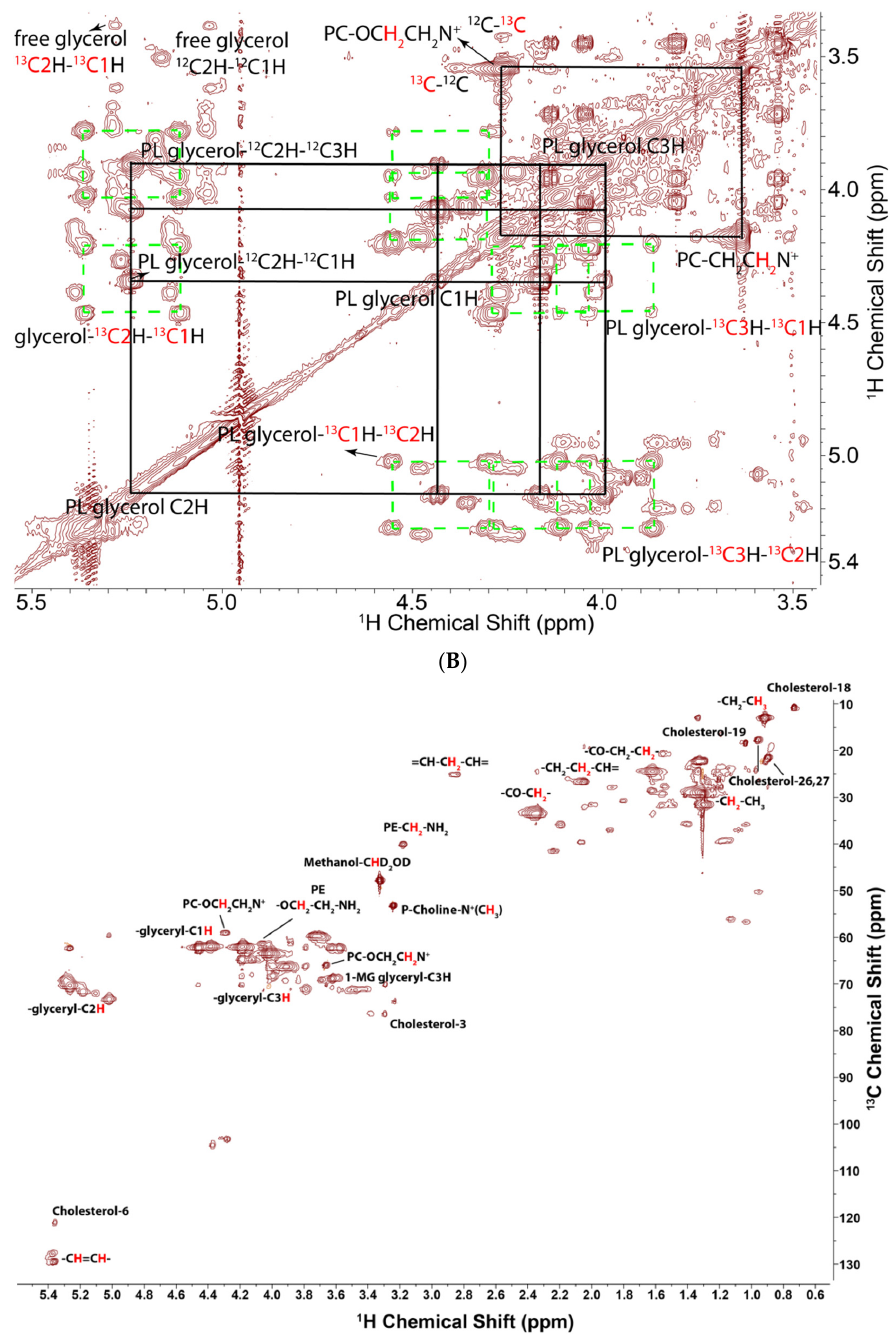
Figure 2. 1 H TOCSY and 1 H{ 13 C}-HSQC spectra of lipids extracted from PC3 cells grown on [U- 13 C]-glucose. TOCSY spectra were recorded at 15 °C, 14.1 T with acquisition tines of 1 s in t 2 , 0.04 s in t 1 with a DIPSI2 (Decoupling In the Presence of Scalar Interactions) spin lock of 50 ms mixing time, and a B 1 field strength of 6.5 kHz. The 2D HSQC spectrum was acquired with 12 ppm in the proton dimension and 200 ppm in the carbon dimension. Acquisition time is 0.25 s in F2 and 8.5 ms in F1. Adiabatic decoupling was applied and a transfer delay of 3.425 ms corresponding to 146 Hz was set for an optimal one bond CH coupling. ( A ) Full spectrum showing different subgroups of complex lipids. ( B ) Downfield region expansion showing cross peaks and 13 C satellites in the glycerol subunits, and cross peaks of the choline headgroup. Green dashed boxes indicate the doubly labeled adjacent carbons in the glycerol backbones. ( C ) HSQC spectrum confirming the assignments from the PRESAT and TOCSY